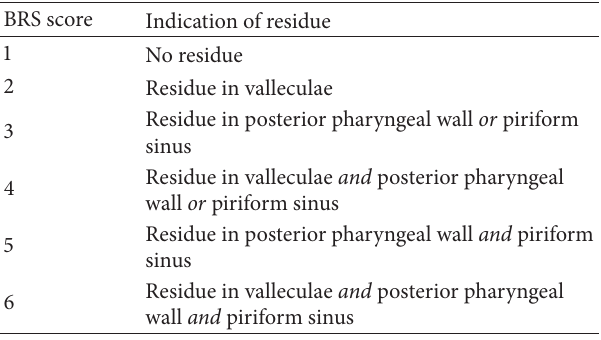
Table 1: Bolus residue scale (BRS) scores according to the number of structures affected by